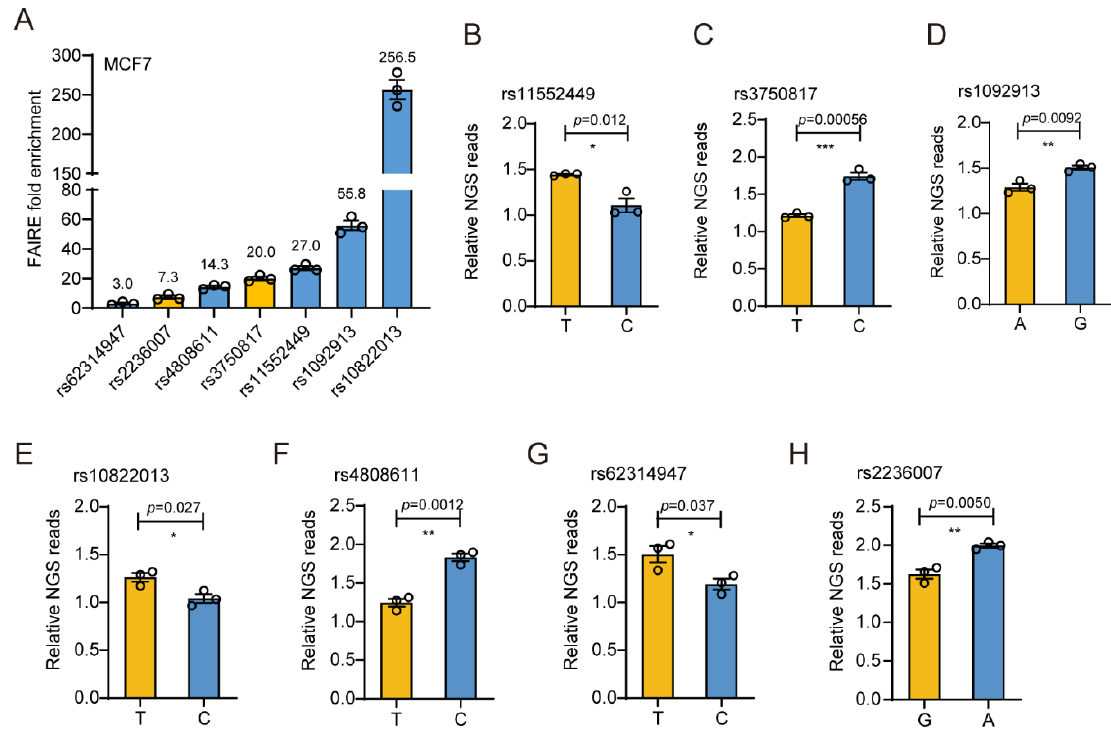
Figure 3. Chromatin openness analysis and gene regulatory activity analysis of seven functional SNPs in MCF7 cells. ( A ) FAIRE enrichment analysis of seven functional SNPs by FAIRE ‐ qPCR in MCF7. Heterozygous SNPs are highlighted in orange. Mean ± SD of three technical replicates. ( B – H ) The reporter activity of both alleles of rs11552449 ( B ), rs3750817 ( C ), rs1092913 ( D ), rs10822013 ( E ), rs4808611 ( F ), rs62314947 ( G ) and rs2236007 ( H ) in DiR ‐ seq analysis in MCF7. Mean ± SD of three biological replicates. * p < 0.05, ** p < 0.01, *** p < 0.001, two ‐ tailed Student’s t ‐ test.